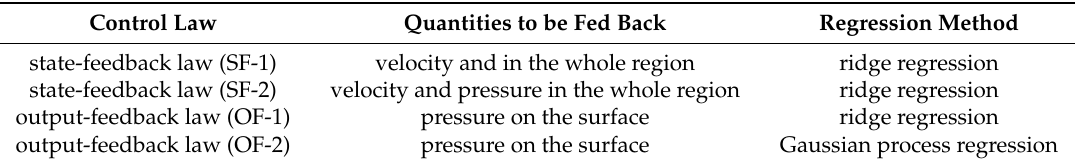
Table 2. Control laws designed by the proposed